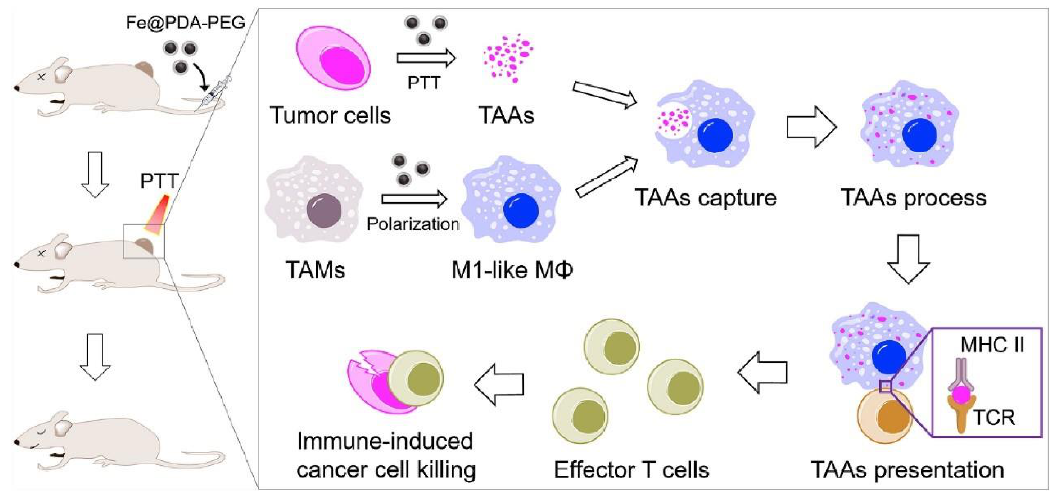
Figure 13. Fe@PDA-PEG induced M2-like TAMs to M1 combined with PTT-induced tumor-associated antigens release for combined anti-tumor therapy [111].